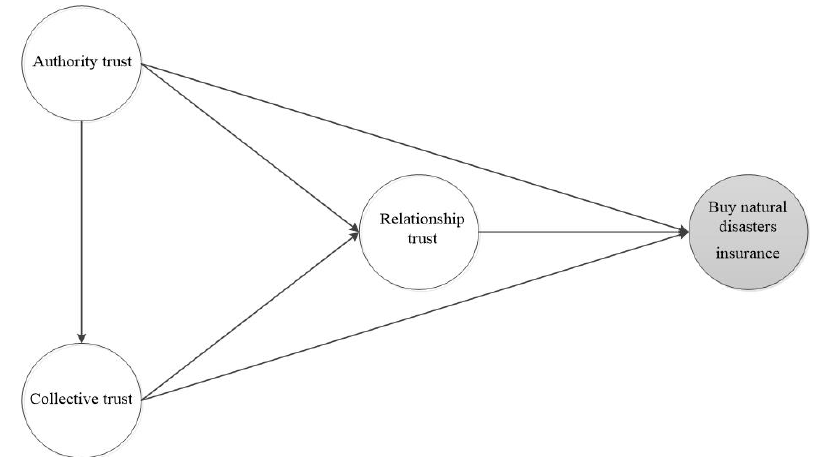
Figure 3. Model construction.